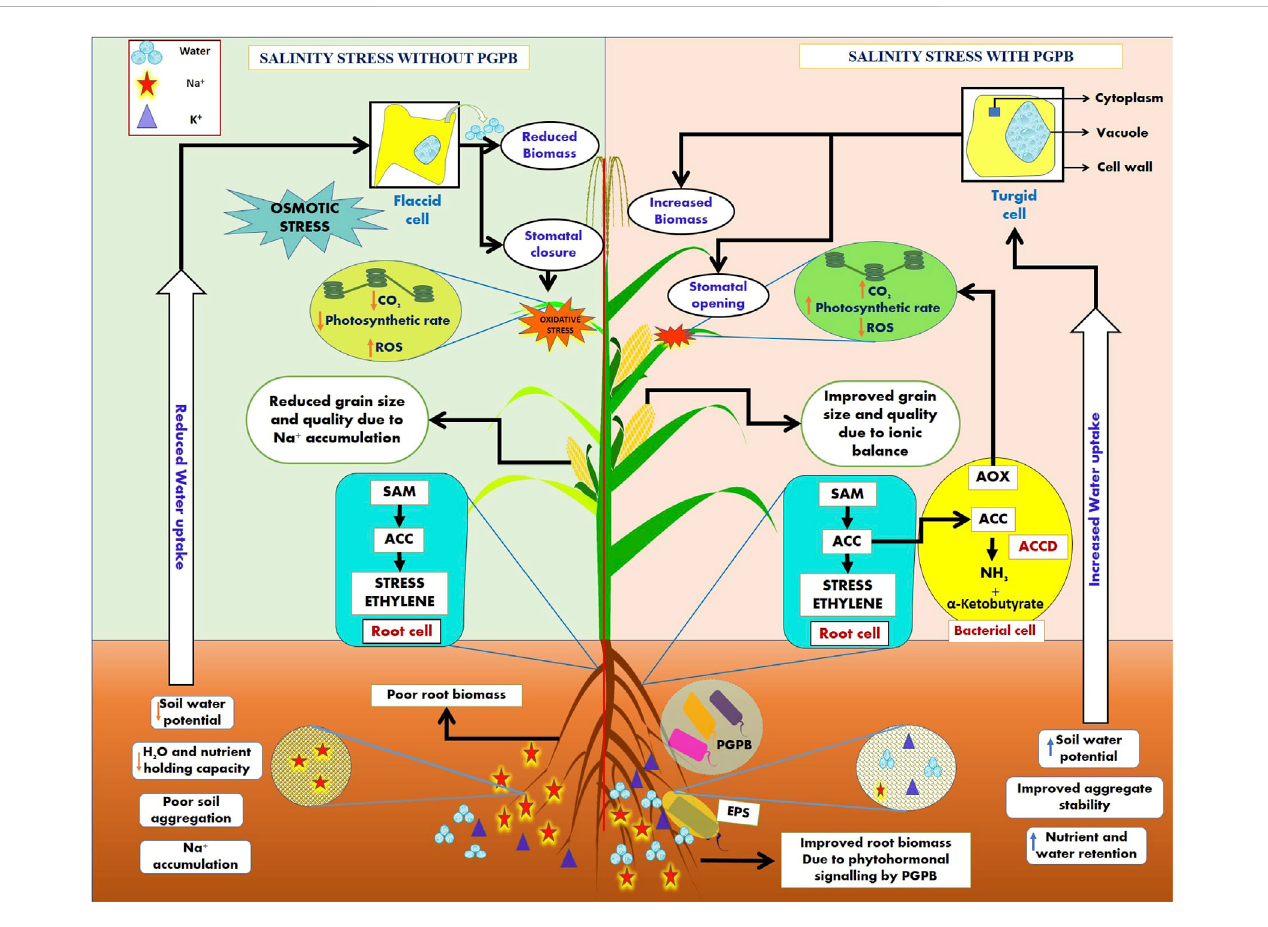
FIGURE 2 Plant growth-promoting bacteria (PGPB) mediate the salinity stress mitigation mechanism in plants via exopolysaccharide (EPS) secretion and the production of an antioxidant enzyme complex (AOX) to reduce reactive oxygen species (ROS) in cell organelles and ACC deaminase (ACCD), which reduces the stress ethylene in salt-stressed cells. The concept of the fi gure was inspired by Egamberdieva et al. (2019), Narsing Rao et al. (2019), and Soni et al.